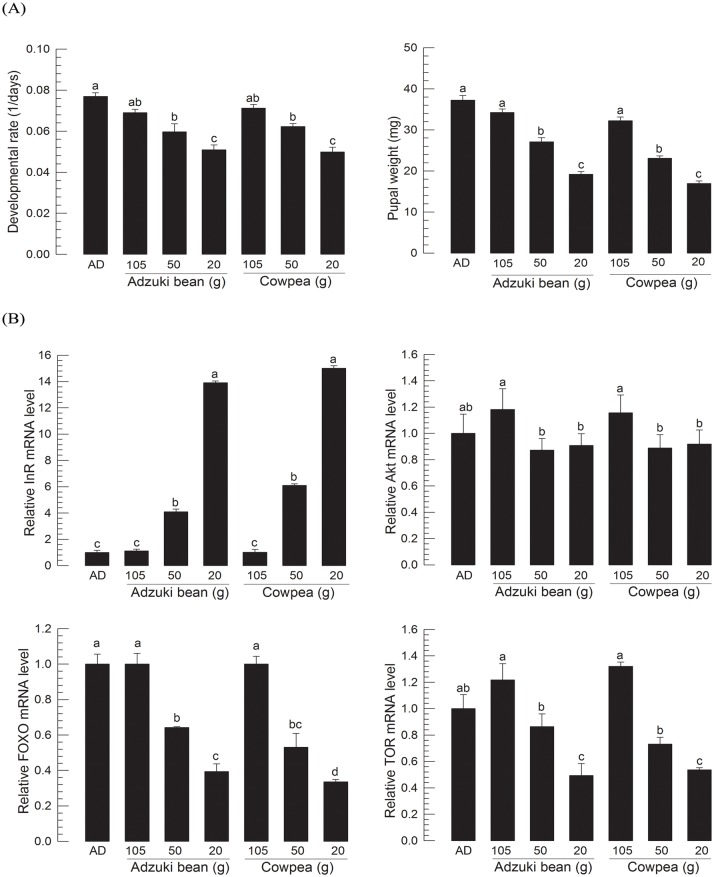
Effect of different nutritional diets on larval growth of M. vitrata.Newly hatched larvae (L1D1) were treated with seven different diets at a constant temperature of 25°C: a standard artificial diet (‘AD’), three adzuki bean diets at different nutritional amounts, and three cowpea diets at different nutritional amounts (S1 Table). (A) Diet effect on larval growth. Developmental rate was calculated by inverse of time period (days) from L1D1 to L5D1 (the first day of fifth instar). Pupal weight was measured within 8 h after pupation. Each diet treatment used 30 larvae. (B) Changes in expression levels of four IIS component genes (InR, Akt, FOXO, and TOR). These four genes’ expression levels in L5D1 of larvae reared with different diets from L1 were quantified. Each treatment used nine randomly selected larvae. mRNA levels were relatively quantified and compared to mRNA level of L5D1 reared with AD diet. Actin was used as reference gene in RT-qPCR to normalize target gene’s expression level. Different letters above standard deviation bars indicate significant difference among means at Type I error = 0.05 (LSD test). (C) Regression between gene expression levels and developmental rates. Dot lines indicate regression lines. Resulting regression equations are shown in Table 1.